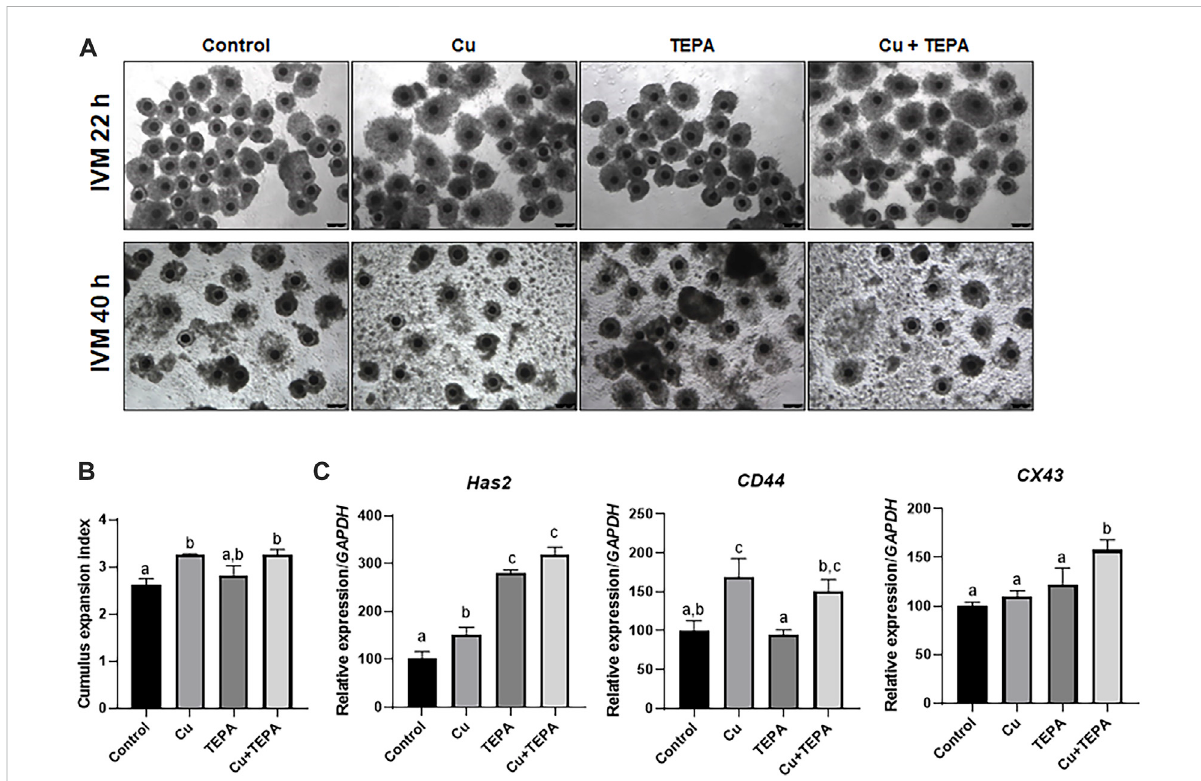
FIGURE 3 Effect of Cu chelation during in vitro maturation (IVM) on cumulus cell expansion in porcine COCs. (A) Representative morphologies of the COCs derived from each group 22 h and 40 h after IVM. Scale bars = 250 μ m. (B) The extent of cumulus cell expansion was assessed using the subjective scoring system. (C) The mRNA expression levels of the cumulus cell expansion-related genes Has2 , CD44 , and CX43 were compared among the cumulus cells from each group. For all graphs, the values represent the mean ± SEM. Values (a – c) with different superscripts within the same column are signi fi cantly different ( p < 0.05). The experiment was replicated